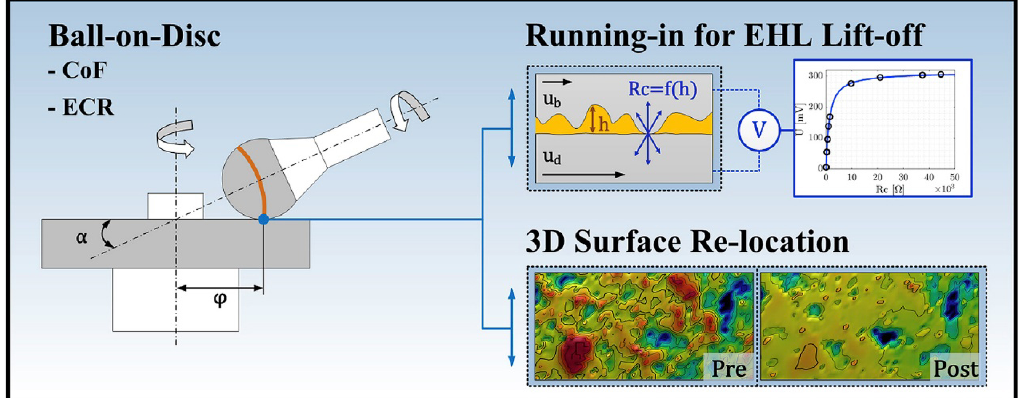
Fig. 2 Surface roughness acquisition procedure for re-location of topographies before and after test [8]. Reproduced with permission from Ref. [8], © Elsevier Ltd.,